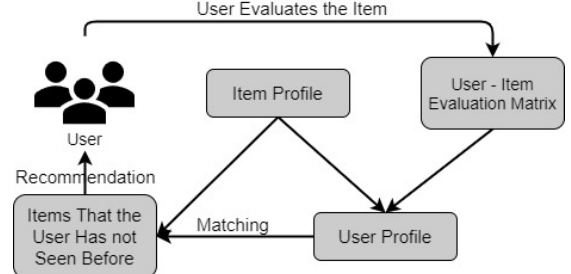
Figure 3. Basic fl owchart of the content-based approach. Figure 3. Basic flowchart of the content-based